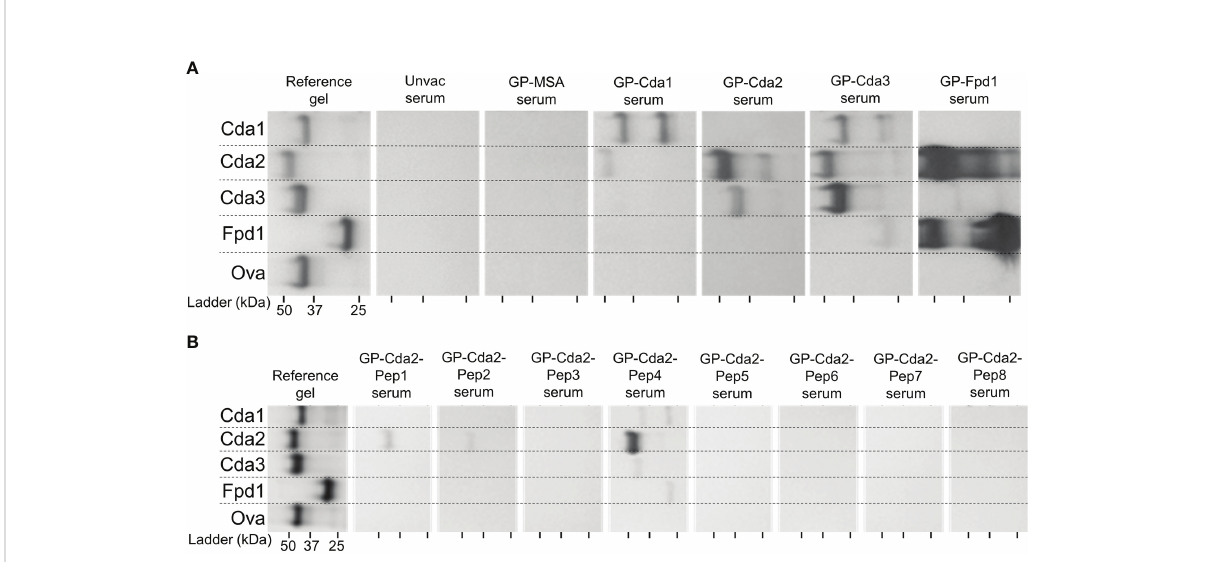
FIGURE 2 Vaccination with any of the Cda family proteins induces serum IgG reactive with at least one other family protein. BALB/c mice were vaccinated as in Figure 1, and mice were euthanized for serum collection two weeks after the fi nal vaccination. The reference gel shows the SDS-PAGE of puri fi ed recombinant proteins used in GP-vaccines. Each lane contains 2 m g of protein, and the gels were stained with Coomassie. To the right are the Western Blots against serum from mice treated with the GP-vaccines. Serum from mice was applied as a primary antibody with a - mouse IgG as the secondary. Serum was pooled from groups of n=4 for the assay. Mice vaccinated with GPs loaded with mouse serum albumin (MSA) served as a negative vaccine control, and recombinant ovalbumin (Ova) was used as a protein control. Blots are oriented such that the top of the gel is on the left, and molecular masses of the protein standards are denoted by the ticks on the bottom such that the left, middle, and right ticks for each blot represent a protein ladder of 50 kDa, 37 kDa, and 25 kDa, respectively. (A) Serum from mice vaccinated with the indicated recombinant protein. (B) Serum from mice vaccinated with the indicated synthesized Cda2 peptide. See Specht et al., 2022 (12) and Figure S3 for the peptide sequences. The Western blots have been rotated and cropped to show the relevant portions but not spliced or digitally